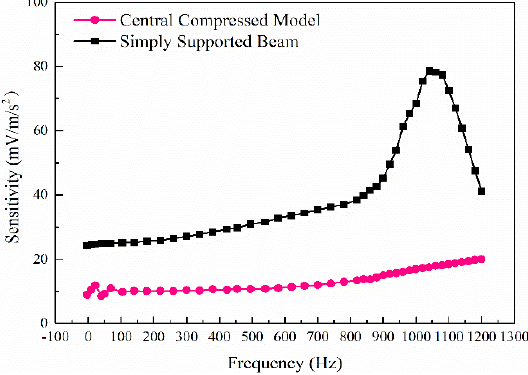
Figure 15. The sensitivity of different structural models.